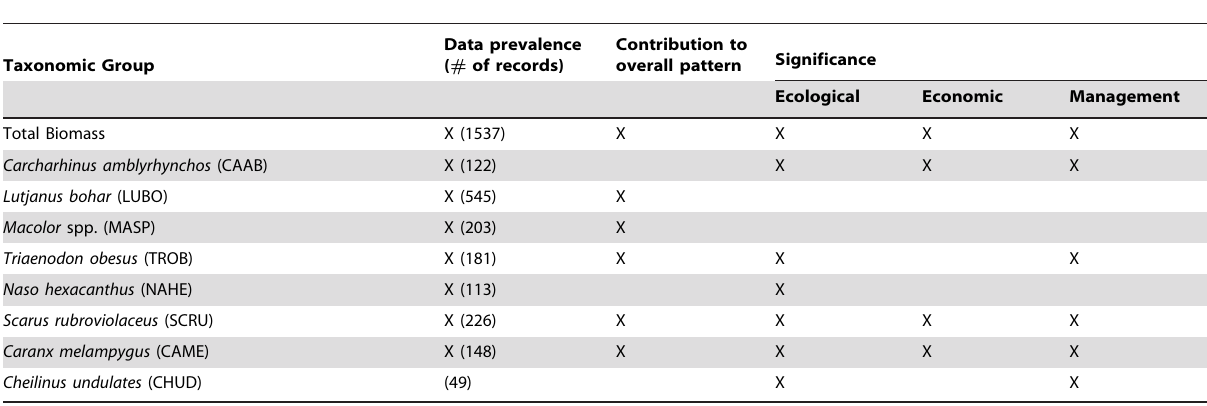
Table 3. List of taxonomic groups and reasons for inclusion in the analysis.